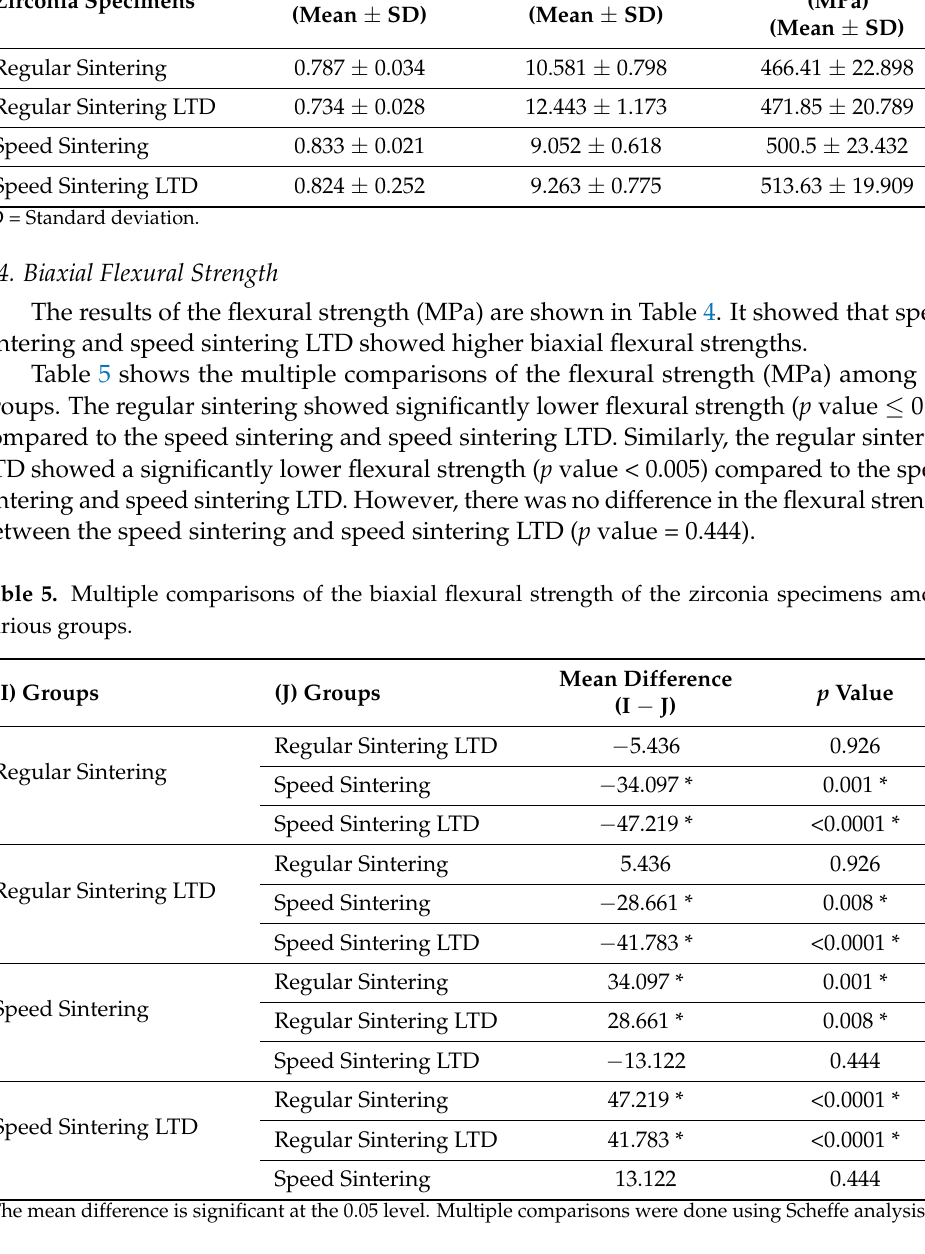
Table 4. Results of the contrast ratios transparency, and biaxial flexural strength of the zirconia specimens. Zirconia Specimens Regular Sintering